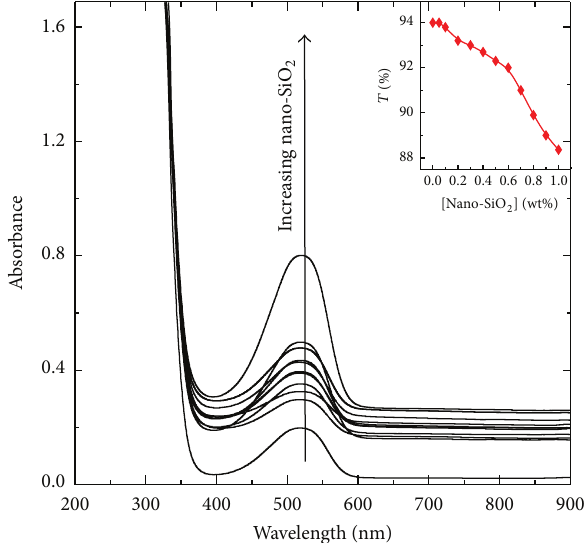
Figure 5: Effect of nanosilica concentration on the absorption and transmission (inset) spectra of design (2) TLSCs.